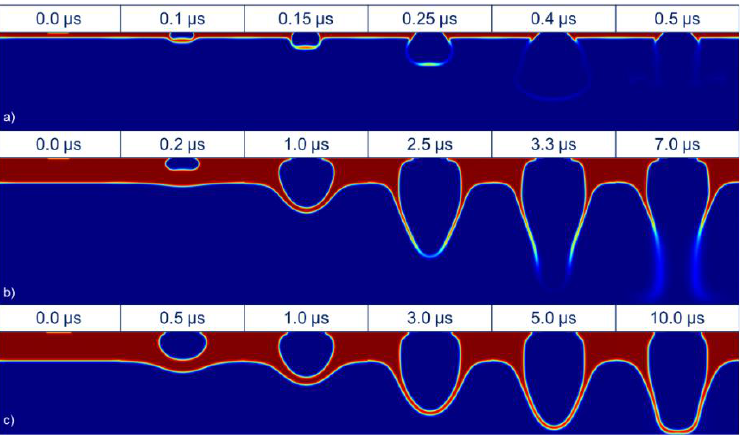
Figure 9. Explosive regime ( a ) simulation of a 2 Pa · s paste for a low thickness (12 µ m) with a bubble pressure of 300 MPa, ( b ) simulation of 2 Pa · s paste for intermediate thickness (60 µ m) with a bubble pressure of 500 MPa, and columnar regime, and ( c ) simulation of 2 Pa · s paste for intermediate thickness (60 µ m) with a bubble pressure of 400 MPa and a gap of 160 µ